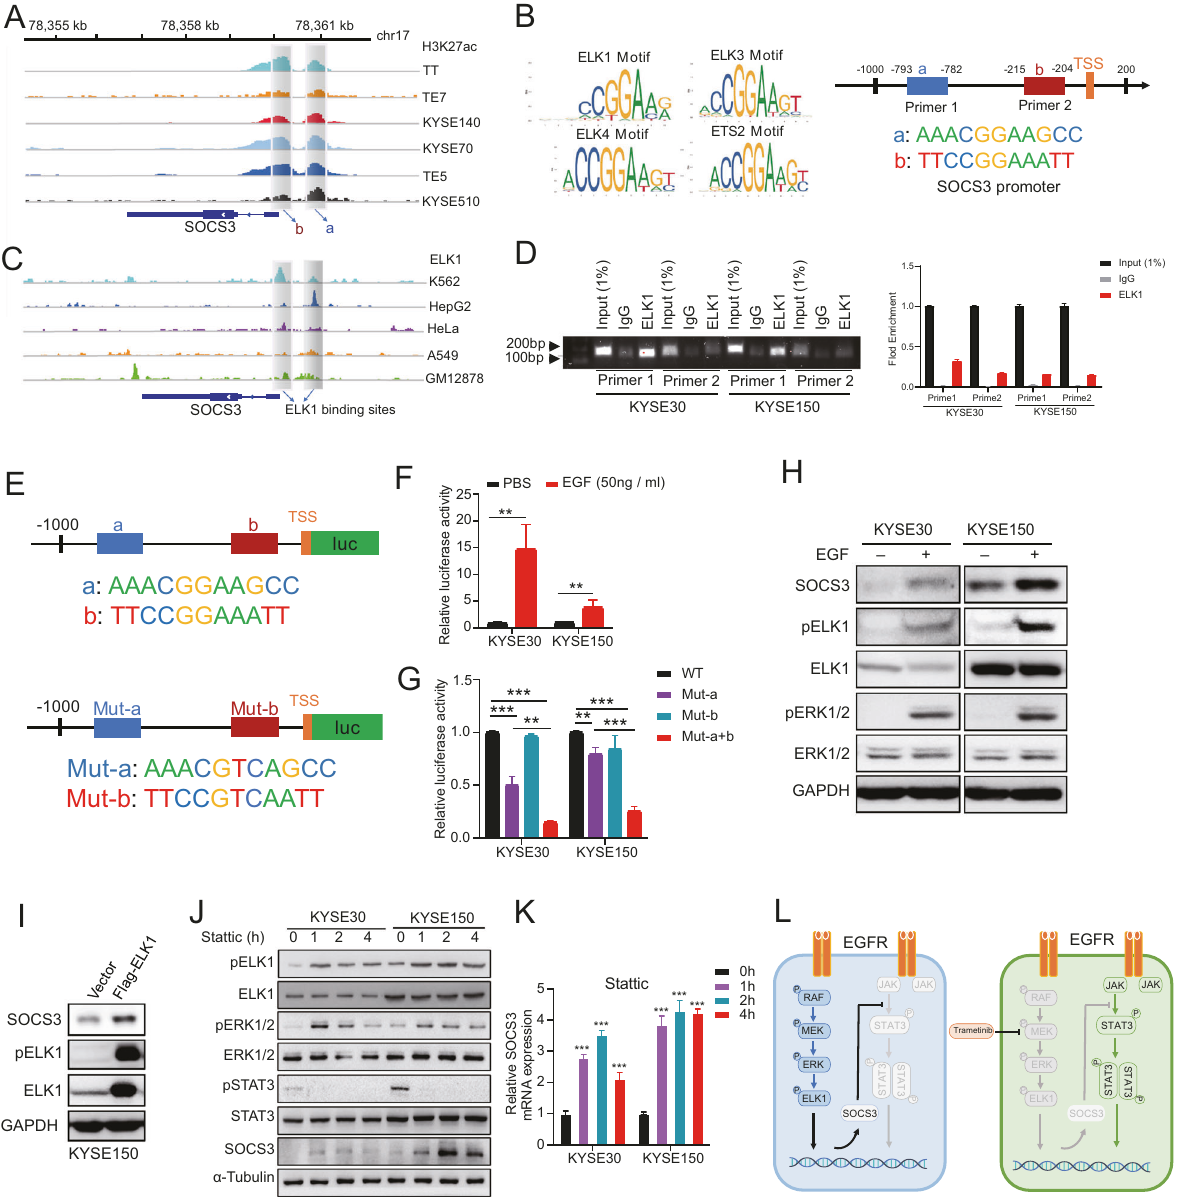
Fig. 5 SOCS3 is a downstream gene of the MEK/ERK/ELK1 signaling pathway. A ChIP-seq analyses of six ESCC cell lines revealed H3K27ac signals at the SOCS3 locus. Shadows highlighting selected constitutive promoters of SOCS3 (a and b). B Predicted sequences of transcription factor motifs at the SOCS3 promoter determined using JASPAR. Predicted sequences of transcription factors ELK1, ELK3, ELK4, and ETS2. C ChIP-seq of ENCODE data for human malignant myeloid K562, human hepatoma HepG2, human cervical cancer HeLa, human lung cancer A549, and human B lymphocyte GM12878 cells revealed binding of ELK1 to the SOCS3 locus. Shadows highlighting selected constitutive promoters of SOCS3 occupied by ELK1. D ChIP-PCR analysis of ELK1 enrichment at the SOCS3 promoter in KYSE30 and KYSE150 cells. Shown are representative electrophoresis (up) and qRT-PCR (down) results of two independent experiments. Error bars represent the mean ± SD. E Schematic diagram of luciferase reporter plasmids which were constructed containing the wild SOCS3 promoter or mutant ELK1 motif. F KYSE30 and KYSE150 were transfected with the WT SOCS3 promoter-reporter. After 24 h, cells were treated with EGF (50 ng/ml) for 6 h and luciferase activity was evaluated. Error bars represent the mean ± SD. G Luciferase activity was evaluated in mutant ELK1 motif reporter- transfected cells after 24 h. Error bars represent the mean ± SD. * P < 0.05, ** P < 0.01, *** P < 0.001. H Western blotting results show the phosphorylation of ELK1 and the expression of SOCS3 after EGF (50 ng/ml) treatment in KYSE30 and KYSE150 cells. I KYSE150 cells were transfected with Flag-ELK1 and SOCS3 expression was detected via western blotting. J Western blotting showed the expression of activated and total ELK1, ERK1/2, STAT3 and SOCS3 expression in KYSE30 and KYSE150 treated with Stattic in a time-dependent manner. K qRT-PCR results show the transcription level of SOCS3 mRNA after Stattic treatment at various time points. Error bars represent the mean ± SD. *** P < 0.001. L As in ESCC, EGFR signaling induced MEK/ERK activation but not STAT3 due to SOCS3 expression. MEKi caused SOCS3 downregulation and STAT3 was activated when EGFR signaling was